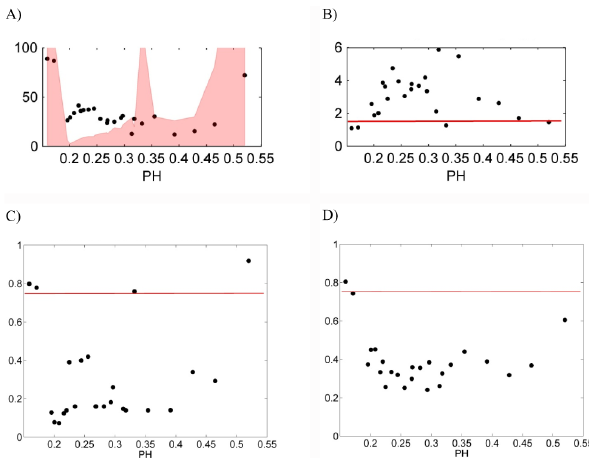
Fig. 15. Statistical analysis of the vegetation clusters for the fields of vegetation as a function of the ratio between annual precipita- tion and annual potential evapotranspiration. (A) Mean size of clus- ters and range 0.025–0.975 quantile of the mean cluster size cor- responding to a binomial process with the same percentage cover. (B) Mean ratio between the span in the x-direction and the span in the y-direction of each cluster; red line represents the boundary between spots and bands. (C) Percentage of the domain filled by the largest cluster; red line represents the minimum fraction of area filled for the field to be considered labyrinthine. (D) Fraction of area of the largest cluster filled by vegetation; red line represents the maximum fraction of the largest cluster that can be filled for the field to be considered